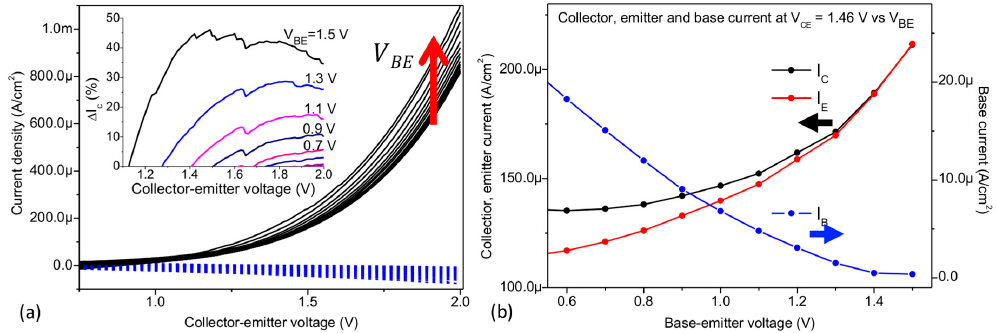
Figure 6. ( a ) Base (blue dashed lines) and collector (black solid lines) current versus V CE at constant values of V BE ranging from 0 to 1.5 V in 100 mV steps. Inset: Percentage increase of I C in function of V BE in respect to I C at V BE = 0 V. ( b ) Variation of the collector, emitter and base currents extracted at V CE = 1.46 V in function of the graphene base plotted versus the base-emitter voltage. (cid:1835) (cid:3003) steadily decreases as (cid:1848) (cid:3003)(cid:3006) increases, while the collector